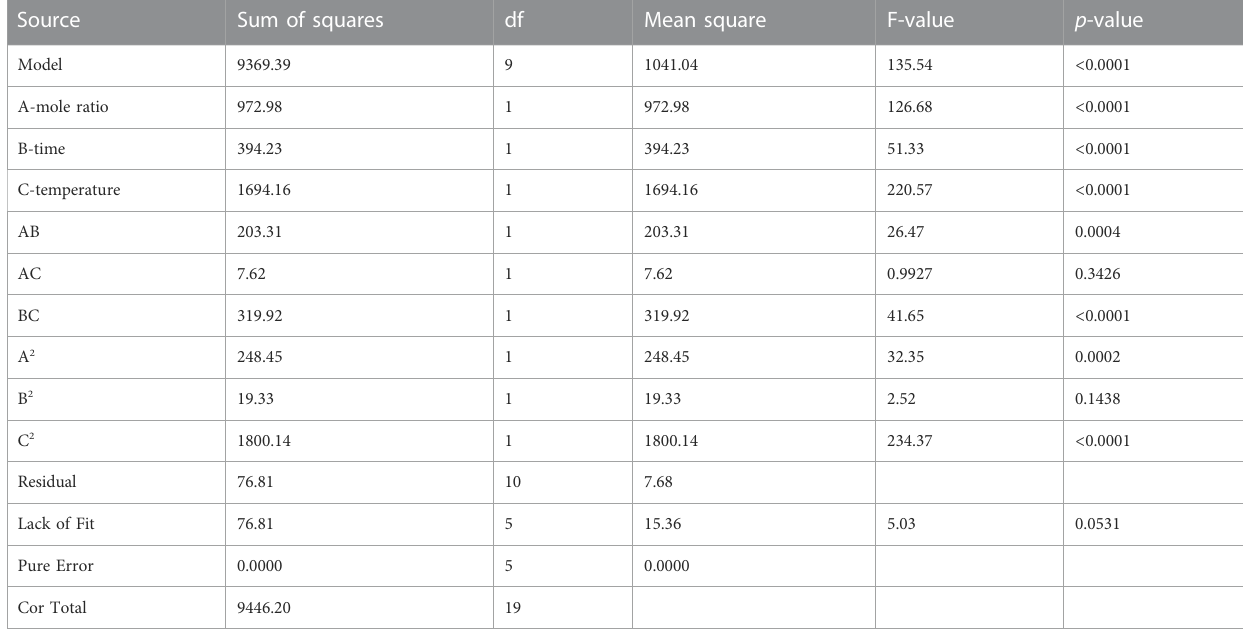
Coding factors is Coded. Sum of squares corresponds to Type III-Partial.